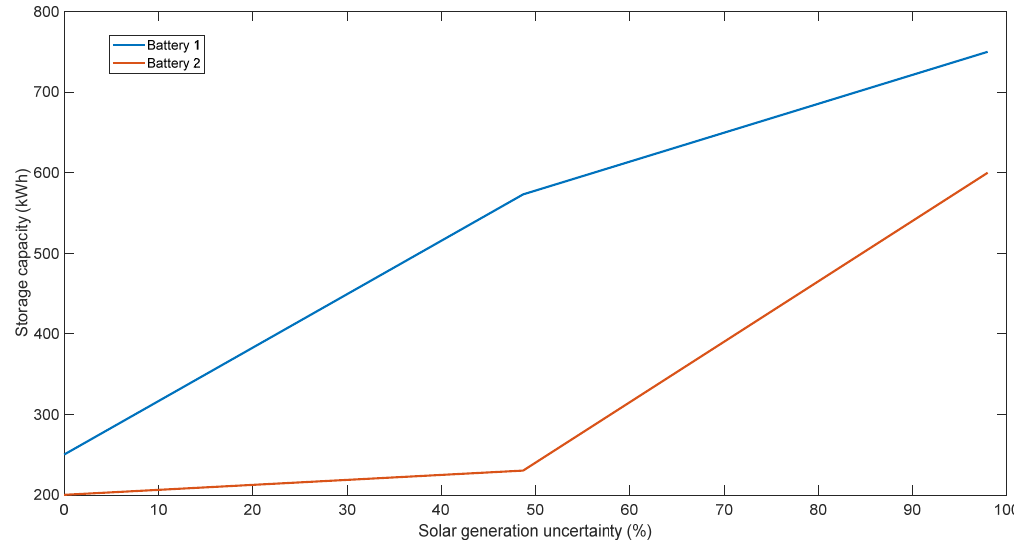
Figure 5. Solar generation uncertainty vs. storage capacity.